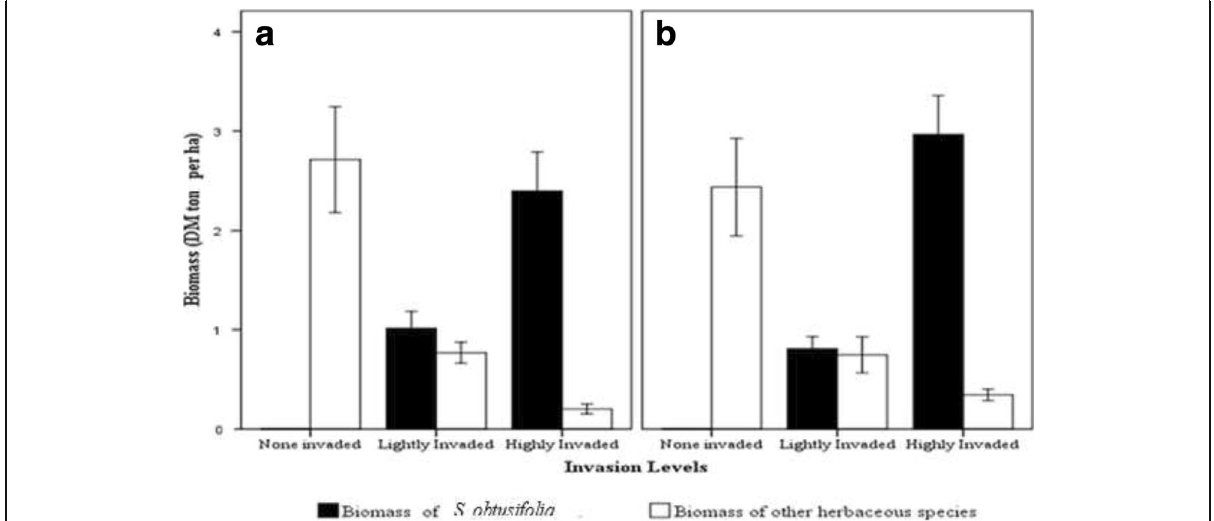
Fig. 6 Biomass yield of S. obtusifolia and other herbaceous vegetation (DM t ha − 1 ) under three invasion levels (non-invaded, lightly invaded, and heavily invaded) at Kafta Humera ( a ) and Tsegede districts ( b ) in the western Tigray region, northern Ethiopia. Bars indicate the SE of the mean